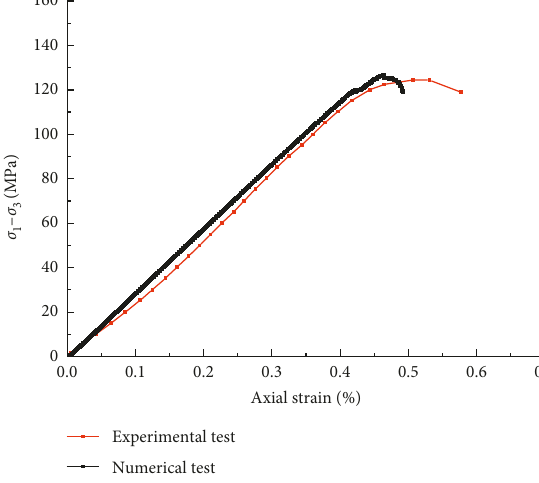
Figure 1: Comparison of stress-strain curves obtained by exper- iment and simulation under triaxial test.